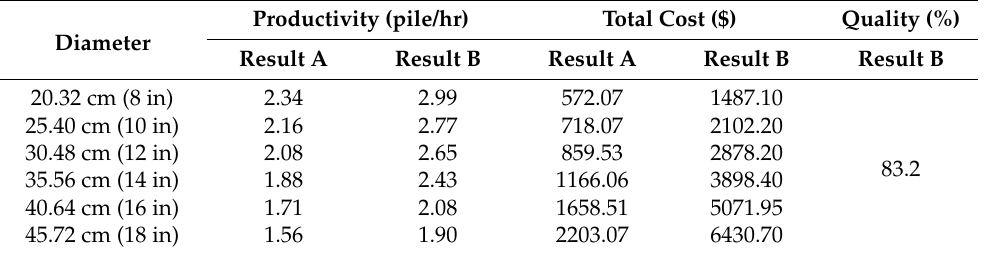
Table 7. Simulation results